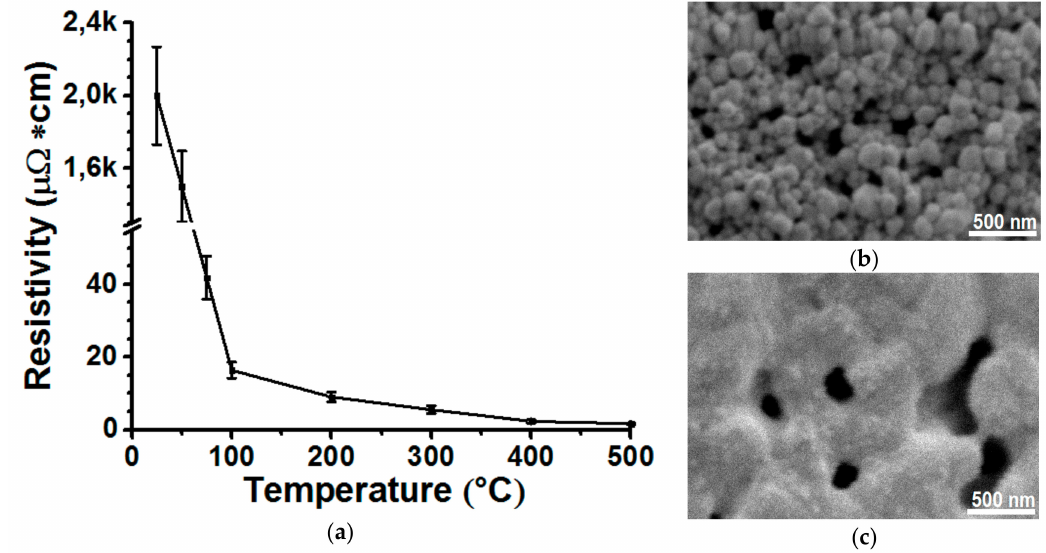
Figure 2. Dependence of the electrical resistivity of the lines from silver nano-ink on the temperature of the substrate heating ( a ); SEM image of a line dried at 100 ◦ C ( b ) and sintered at 400 ◦ C ( c ), respectively. The formation of the lines was carried out at T s = 25 ◦ C, N = 1 layer, FR = 5 and V s = 100 mm /